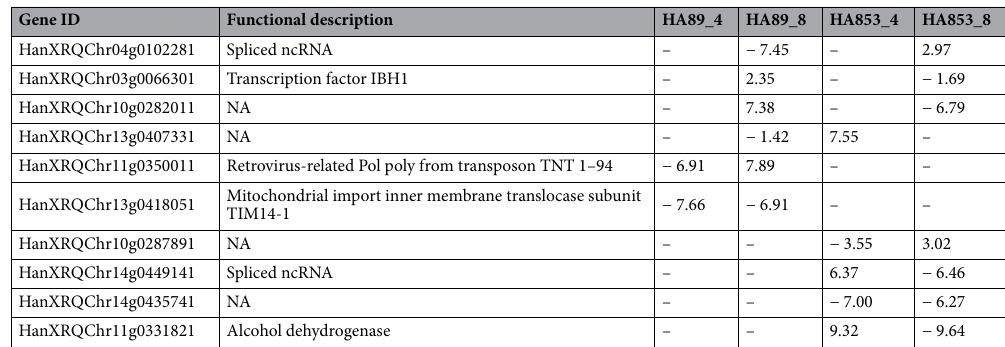
Table 1. Functional description and logFC values of the DEGs shared by the different IL-time point combinations and/or time points within ILs.